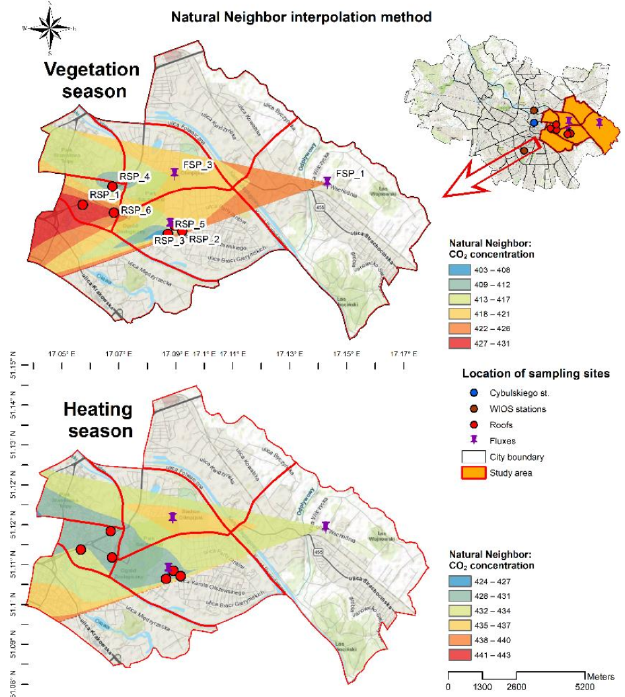
Figure 12. GIS coupling mapping of spatial CO 2 distribution in the vegetation and heating seasons, a surface produced using the natural neighbor interpolation method.